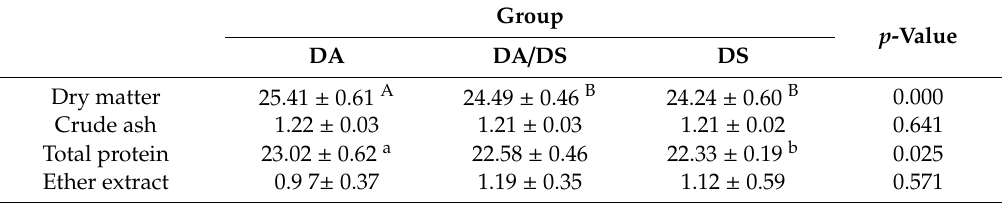
Table 7. Proximate chemical composition of hind leg muscles in rabbits (%; mean ± SD; n = 10).